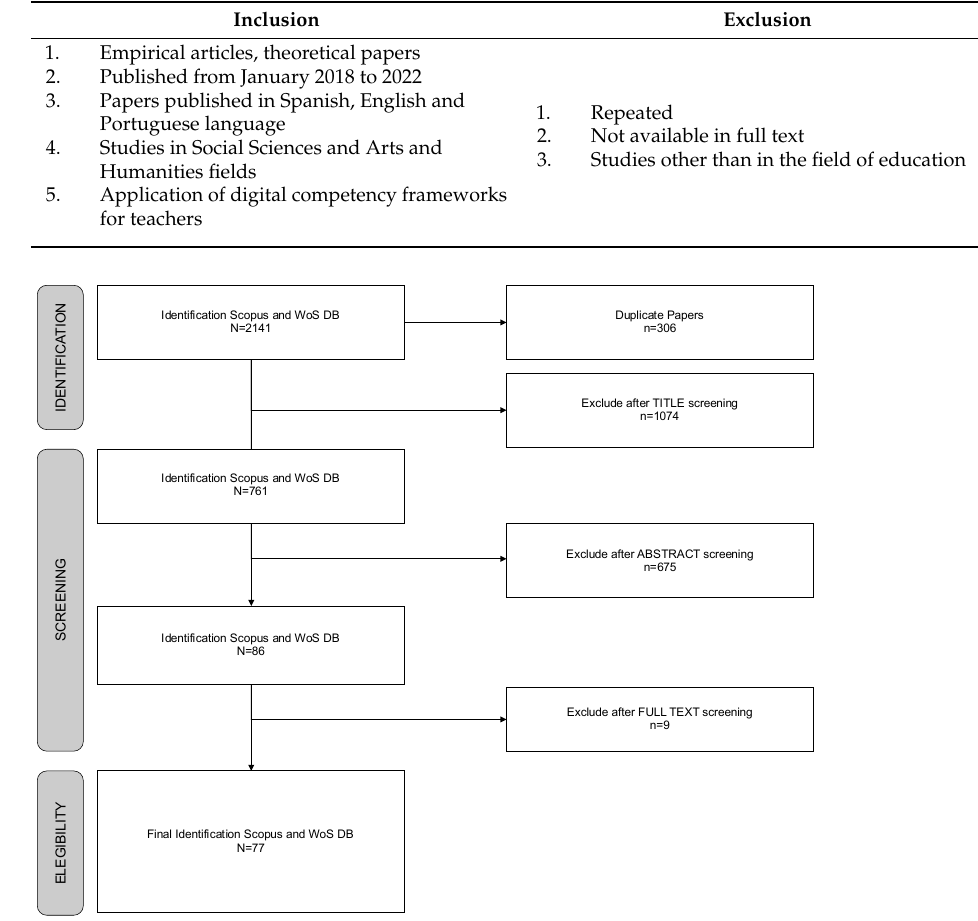
Figure 2. Flowchart for document selection.